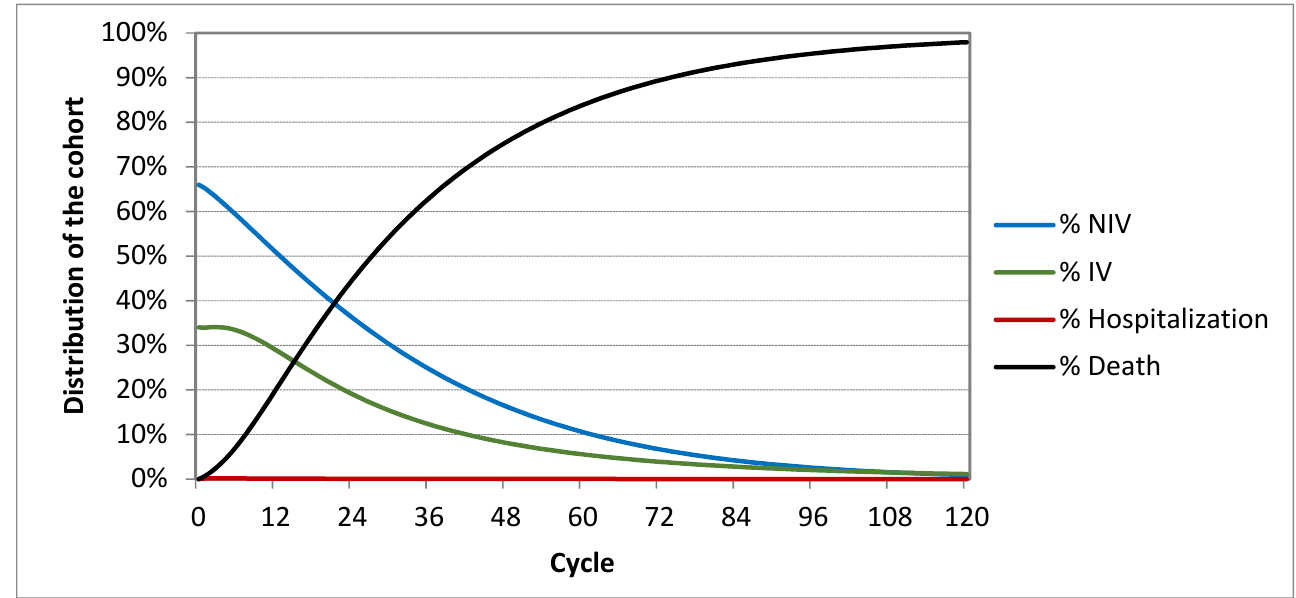
Figure 2. Distribution of cohort in individual cycles of home mechanical ventilation (“HMV“).